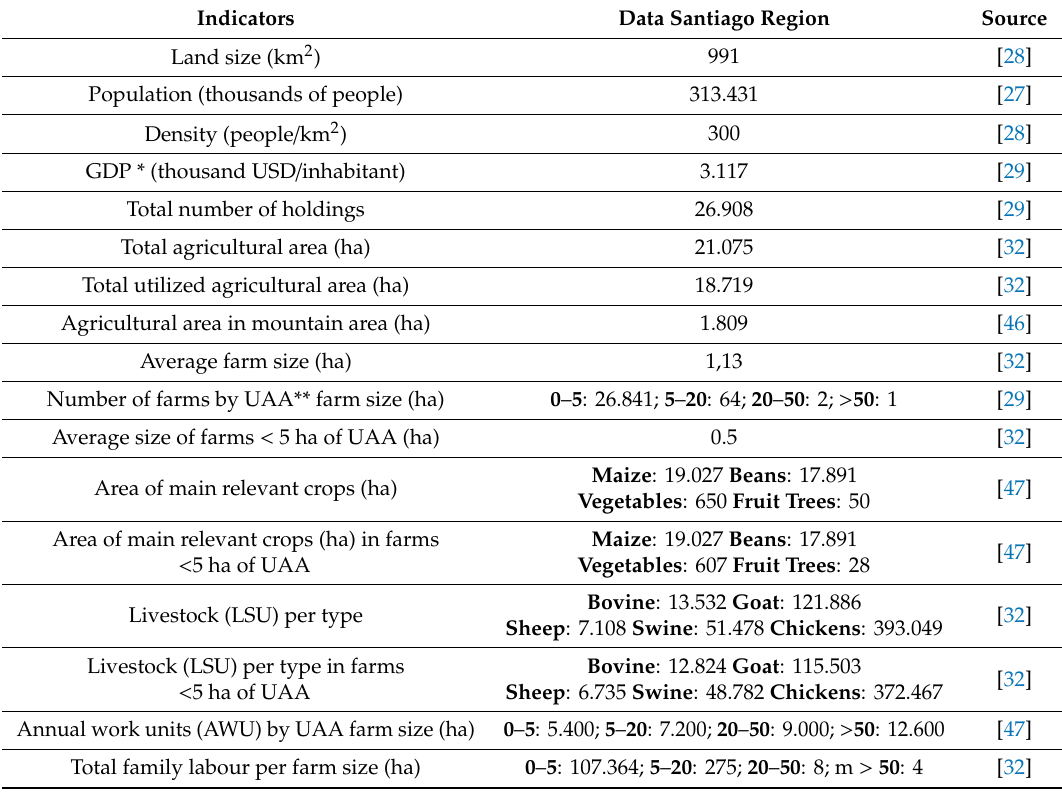
Table 1. Basic data for Santiago